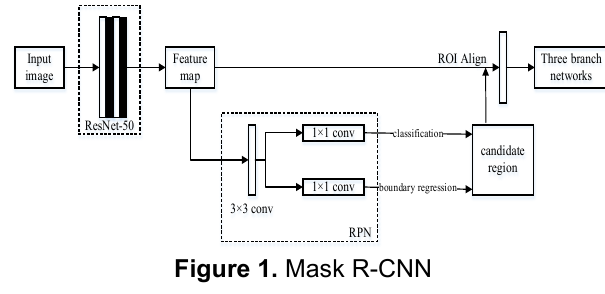
Figure 1. Mask R-CNN